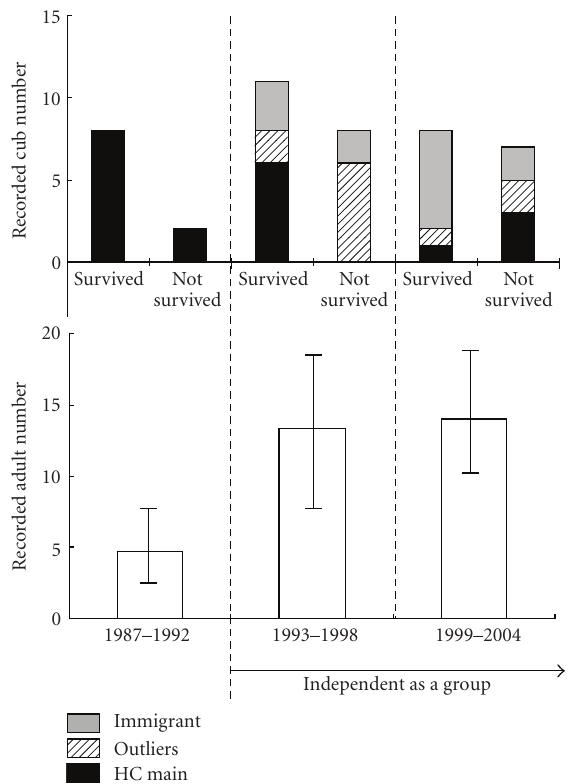
Figure 4: Cub survivorship (above) and adult numbers (below) in the Hill Copse territory in Wytham between 1987 and